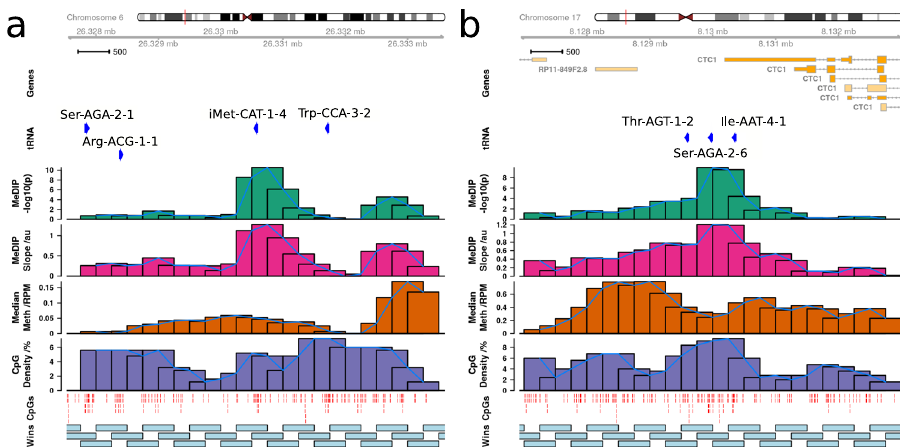
Fig. 3 Age-related tRNA gene DNA hypermethylation is localised to individual tRNA genes. MeDIP-seq results (blood cell-type corrected model) for a tRNA-iMet-CAT-1-4 as well as b tRNA-Ser-AGA-2-6 and tRNA-Ile-AAT-4-1 exhibiting ageing-related DNA hypermethylation. Top to Bottom: chromosome ideogram; gene locations (GENCODE 19); MeDIP-seq DNA methylation ageing − log 10 p value results (shown for each 500 bp overlapping window); MeDIP-seq slope of change with age; MeDIP-seq Medium coverage (Reads per Millions, RPM) calculated across all samples; CpG density (%); CpG locations (red lines); 500 bp overlapping windows. The sharp peaks suggest that the results are localised to individual tRNA genes, not the entire genic locus. One window overlapping tRNA-Ile-AAT-4-1 also partially overlaps tRNA-Ser-AGA-2-6. The 3 ′ UTR of the CTC1 transcript CTC1-201 (ENST00000449476.7, GENCODE 19), which is subject to nonsense-mediated decay, overlaps tRNA-Ile-AAT-4-1. tRNA genes with similar CpG density